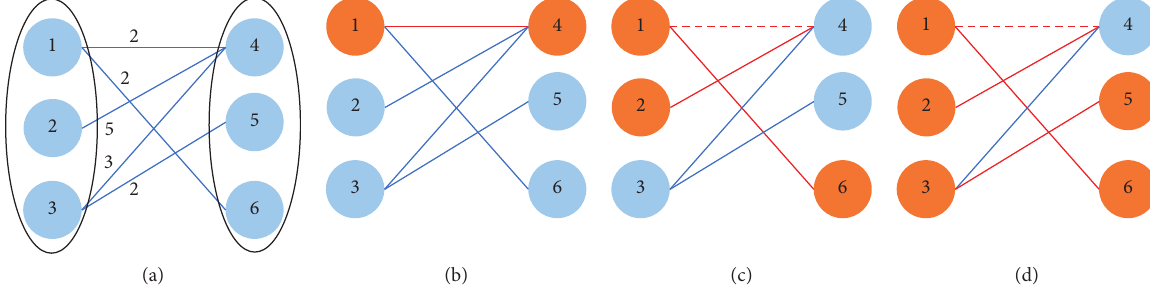
Figure 1: A simple example of the Hungarian method. (a) This is a simple bipartite network where the value on each edge is matching cost. Red circles indicate the matched nodes and blue circles indicate the unmatched nodes. (b) Firstly, let node 1 match node 4. Now, the matching degree is 1. (c) Node 2 can only link with node 4. Although node 4 has already matched node 1, it can be replaced by node 6 at the same cost. Therefore, let node 1 match node 6 instead and node 2 matching node 4 can give a minimum cost. So, the matching degree becomes 2. (d) Finally, let node 3 match the node 5. In this example, the maximum matching degree is 3 at minimum